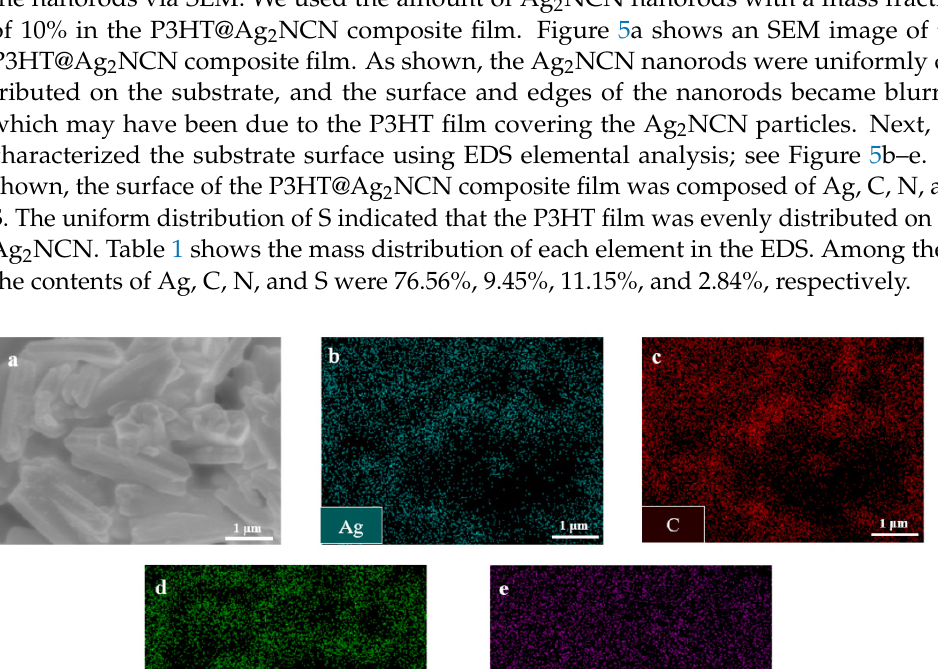
Figure 4. ( a ) UV diffuse reflectance and ( b ) K-M equation curve of Ag 2 NCN before and after treat- ment.